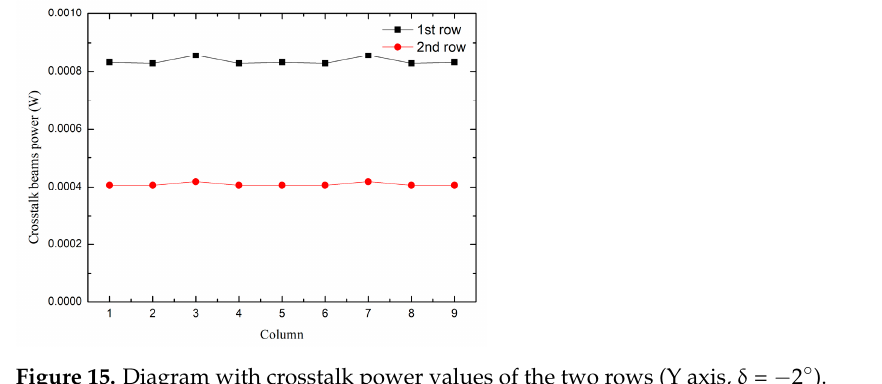
Figure 15. Diagram with crosstalk power values of the two rows (Y axis, δ = − 2°). As the crosstalk value in the second line is generated by the edge array, the crosstalk value is reduced compared with the first line, which makes the curves of the two lines have a certain distance. Increasing the size of the light source can reduce the distance.